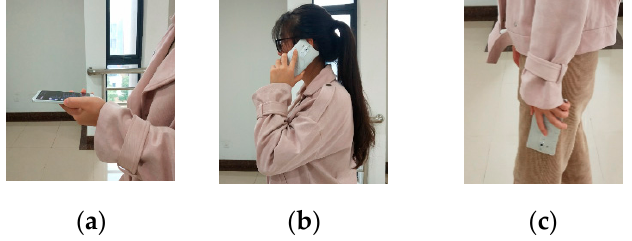
Figure 5. Different smartphone modes: ( a ) normal mode; ( b ) phone mode; ( c ) swinging-hand mode.